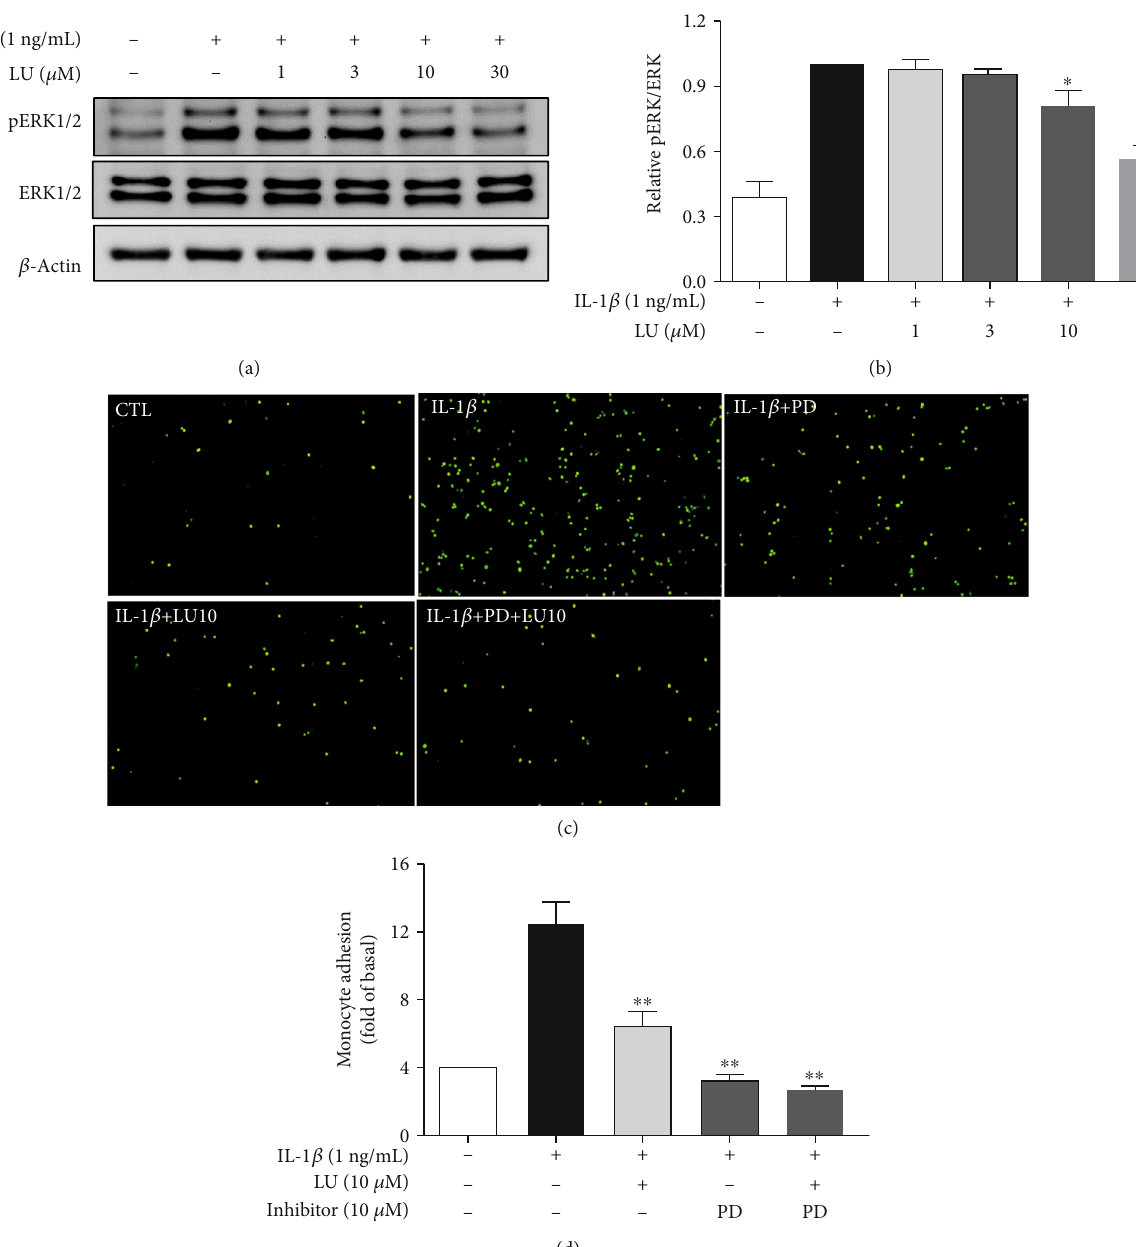
Figure 6: Luteolin blocked ERK phosphorylation and the ERK inhibitor PD98059 (PD) decreased THP-1 cell adherence to IL-1 β -stimulated ARPE-19 cells. (a) Western blots show levels of phosphorylated ERK protein expression. (b) The fold-change in pERK protein expression was measured relative to ERK expression. (c) ARPE-19 cells were pretreated with 10 μ M luteolin or ERK inhibitor (PD98059) for 1h and then cocultured with labeled THP-1 cells. (d) The fl uorescence intensity was used to quantify calcein-AM fl uorescence. Data represent the mean ± SD . ∗ p < 0 : 05 , ∗∗ p < 0 : 01 , compared to ARPE-19 cells stimulated with IL-1 β